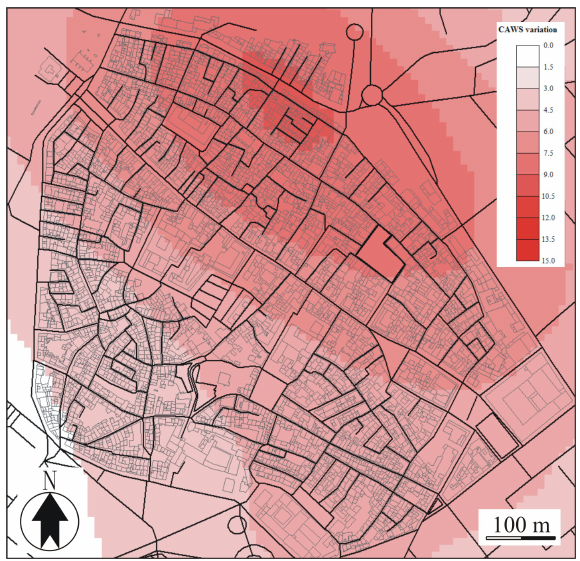
Figure 6. Effect in terms of variation of CAWS due to the transformations hypothesised in Figure